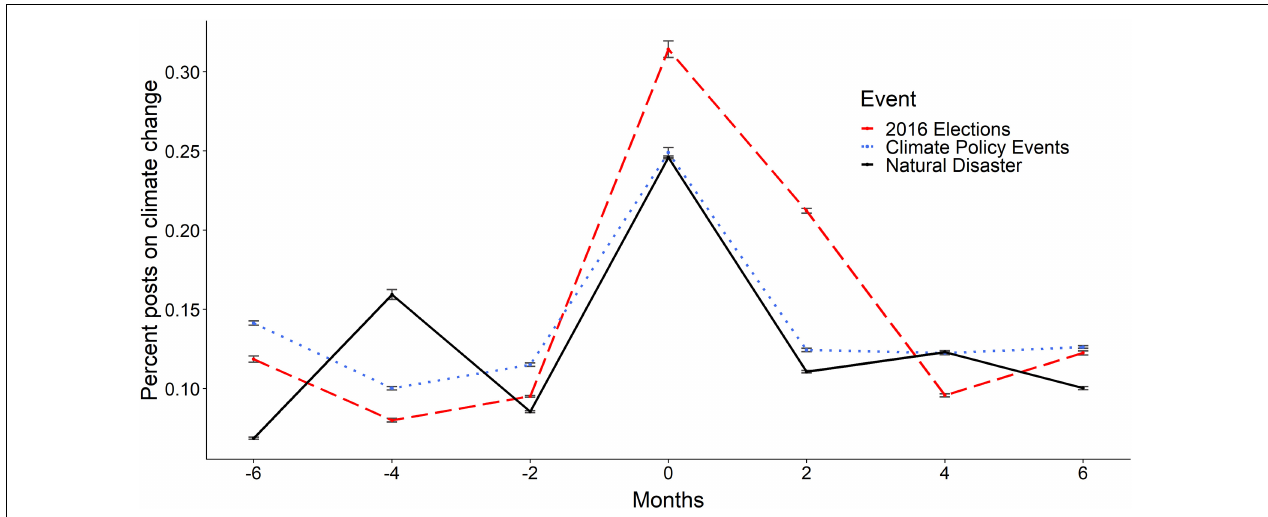
FIGURE 1 | Bi-monthly rate of discussion on climate change surrounding (1) city-relevant natural disasters (e.g., Hurricane Harvey; black solid line), (2) the 2016 United States Presidential elections (red dashed line), and (3) climate-related policy events (e.g., IPCC special report release; blue dotted line). Note: Month 0 refers to the month of the event